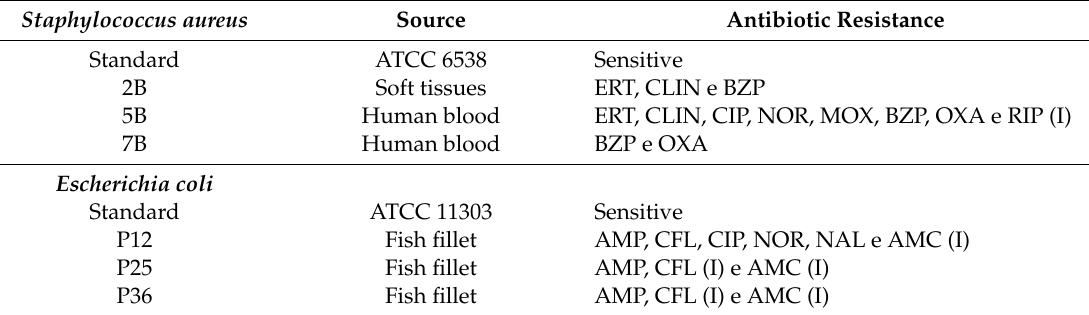
Table 4. Antibiotic resistance profile obtained by the VITEK ® 2